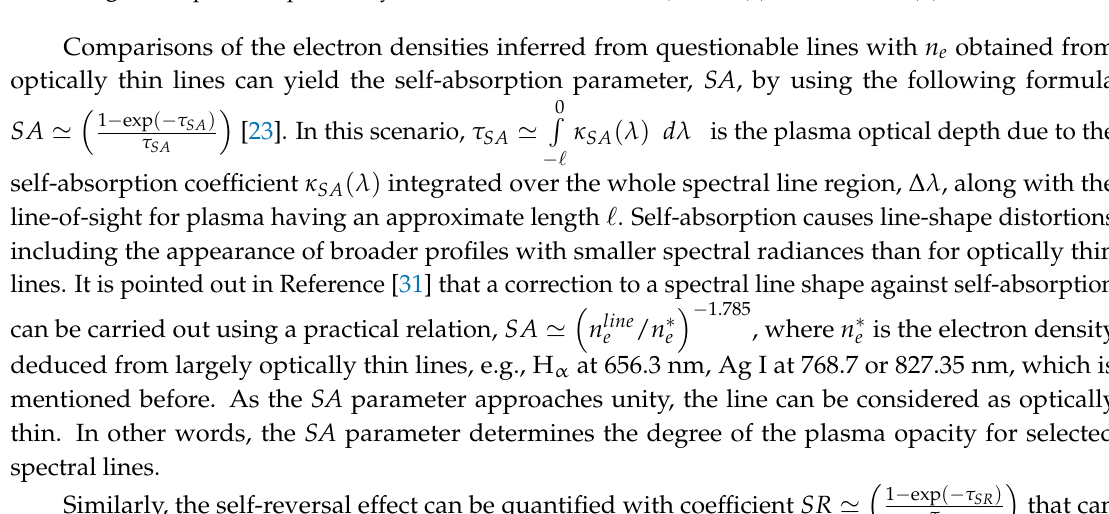
Figure 4. Spectral dips and asymmetries at a fluence of 9.6 J/cm 2 . ( a ) 327.9 nm and ( b ) 338.2 nm.